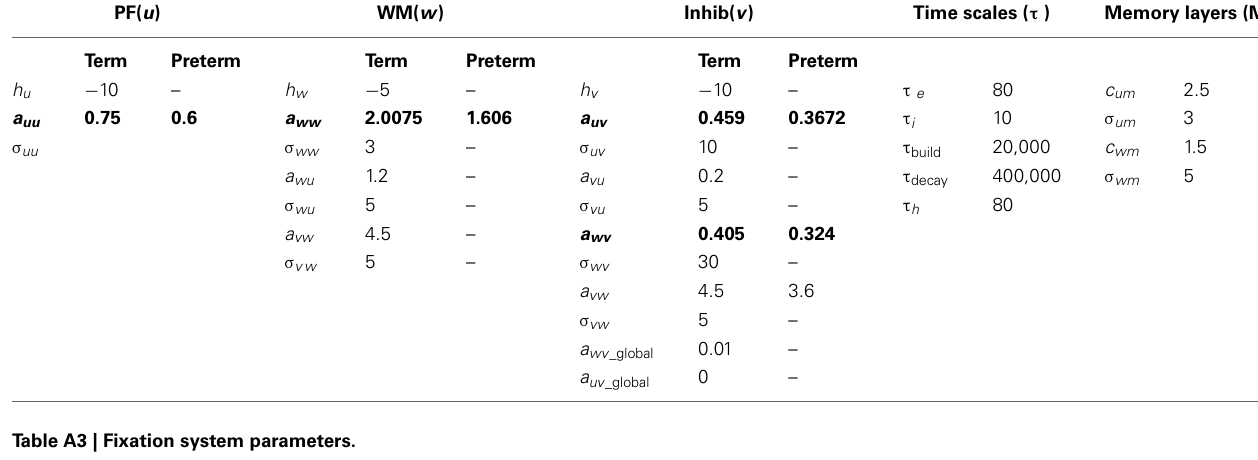
Table A3 | Fixation system